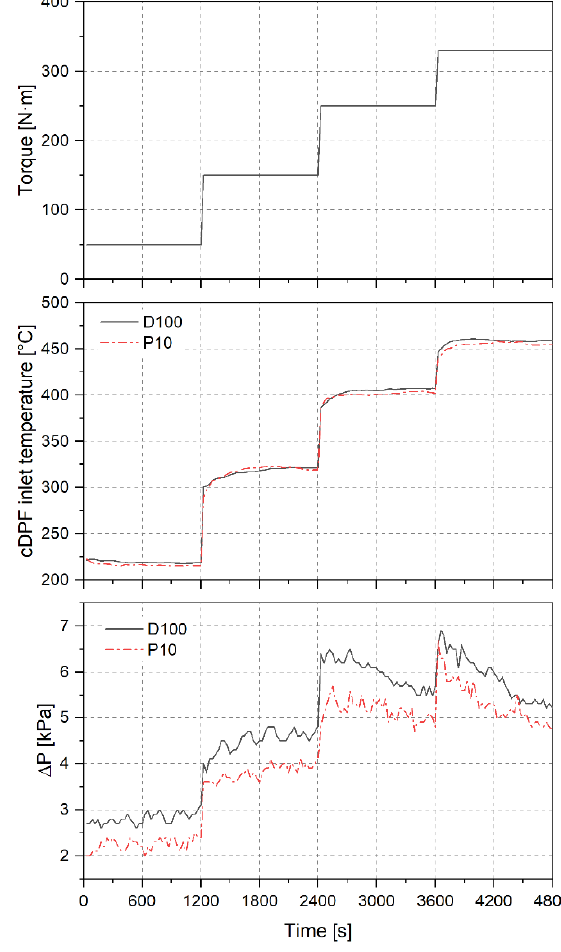
Figure 5. Engine torque, cDPF inlet temperature, and ΔP during the BET procedure.